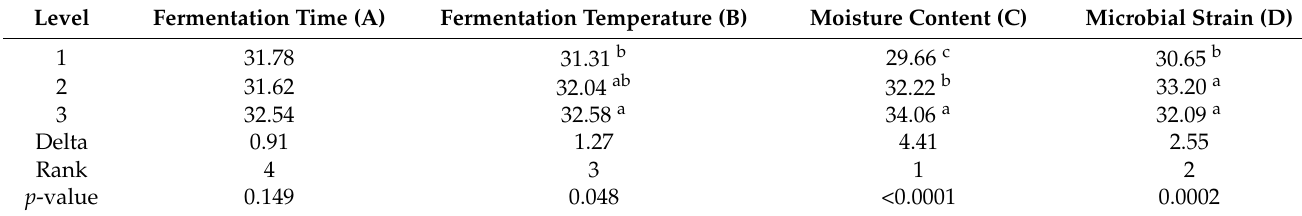
Table 5. Effects of different factor levels on NDF of TMR with